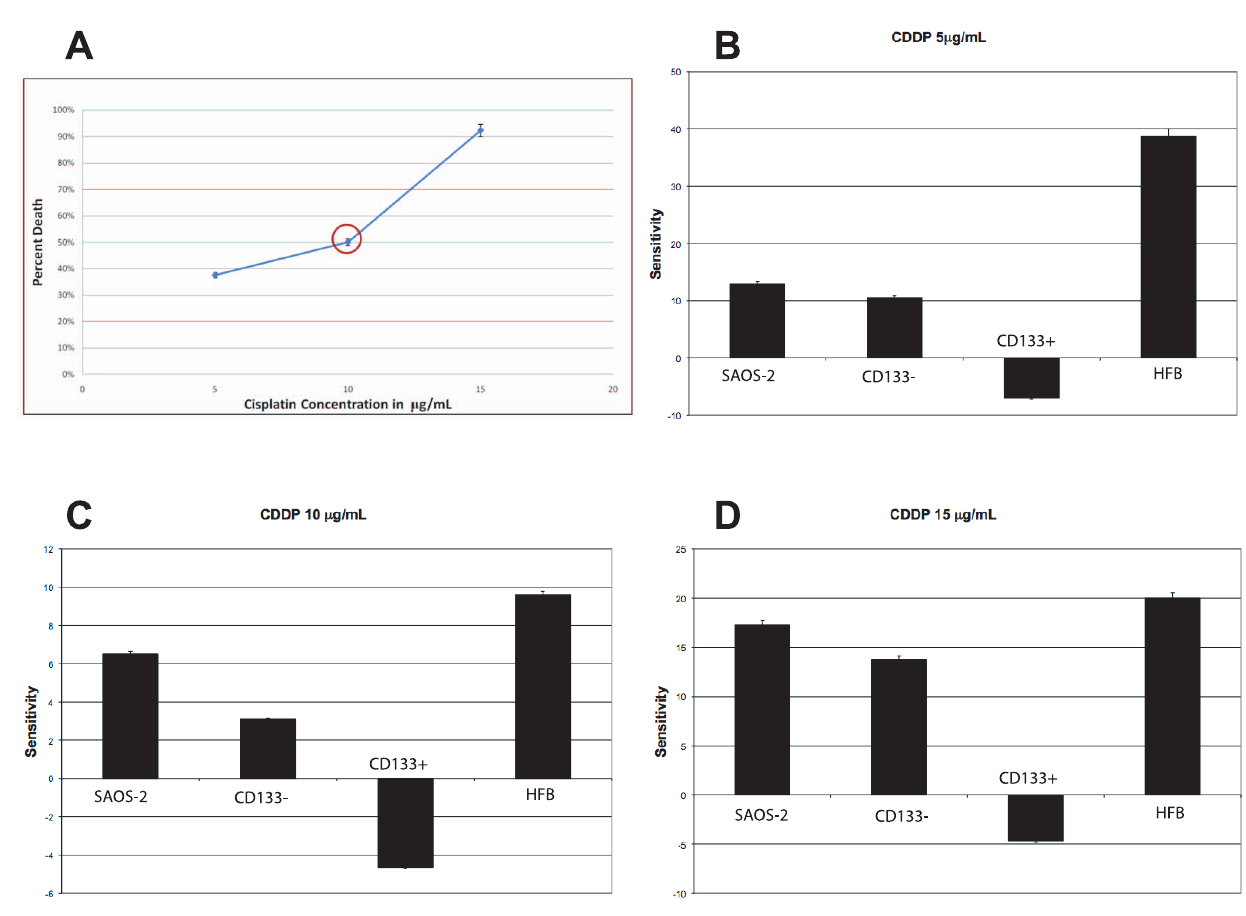
Figure 7. Sensitivity of SAOS-2 cells to cisplatin following growth in simulated hypogravity. A ) LD 50 for cisplatin determined for the SAOS-2 cells. An LD 50 of 10 m g/mL for cisplatin was determined exposing the SAOS-2 cells to a 24-hours treatment using the MTT assay. Comparable results were obtained with cell count by trypan blue exclusion. B ) Histogram showing the sensitivity of SAOS-2 cells to 5 m g/mL of cisplatin following a 24-hours treatment, using an MTT assay. CD133( + ) cells are resistant to the chemotherapy treatment, but the CD133( + ) SAOS-2 cells proliferated and selected with the HFB culture system are sensitive, instead. C ) Histogram showing the sensitivity of SAOS-2 cells to a clinically relevant dose of 10 m g/ mL of cisplatin following a 24-hours treatment, using an MTT assay. CD133( + ) cells are resistant to the chemotherapy treatment, but the CD133( + ) SAOS-2 cells proliferated and selected with the HFB culture system are sensitive, instead. D ) Histogram showing the sensitivity of SAOS-2 cells of 15 m g/mL of cisplatin following a 24-hours treatment, using an MTT assay. CD133( + ) cells are resistant to the chemotherapy treatment, but the CD133( + ) SAOS-2 cells proliferated and selected with the HFB culture system are sensitive, instead.